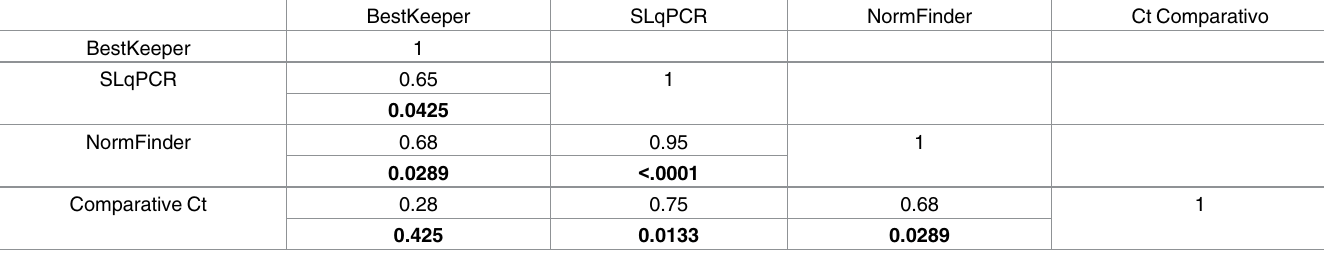
Table 9. Spearman correlation comparing all tools based on the averageordering of referencegenes